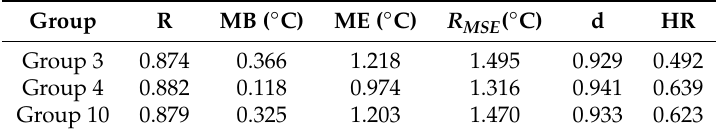
Table 9. Statistical results for the 2-m